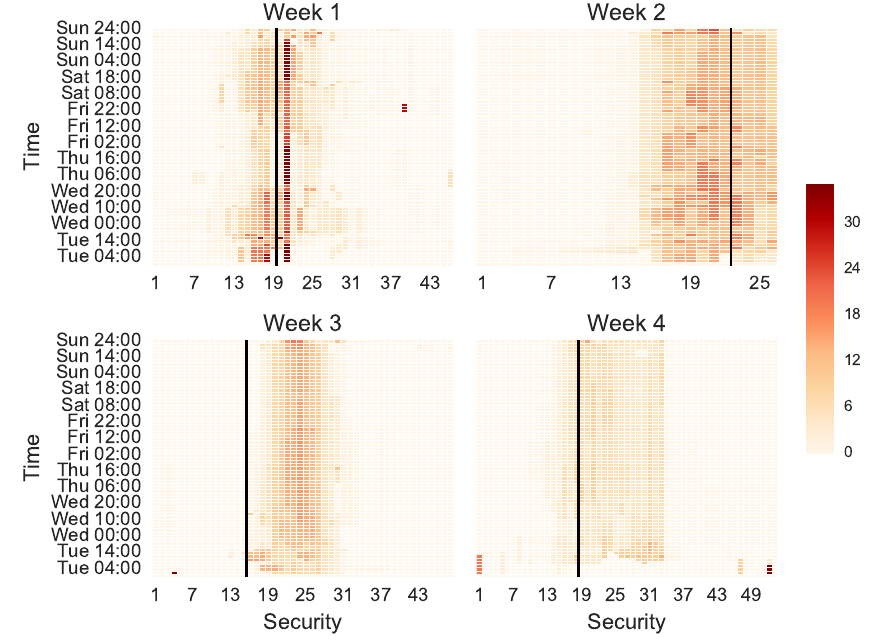
Figure A.2: Experiment 1: The evolution of security prices over time. Within a trading period (one week) the prices were generally stable; price levels were established rather early in the week and remained relatively constant. In week one, the distribution of prices was very peaked, with one security emerging as a clear favourite. The tendency however diminished over periods, and by the last week of the experiment, aggregate price levels were much